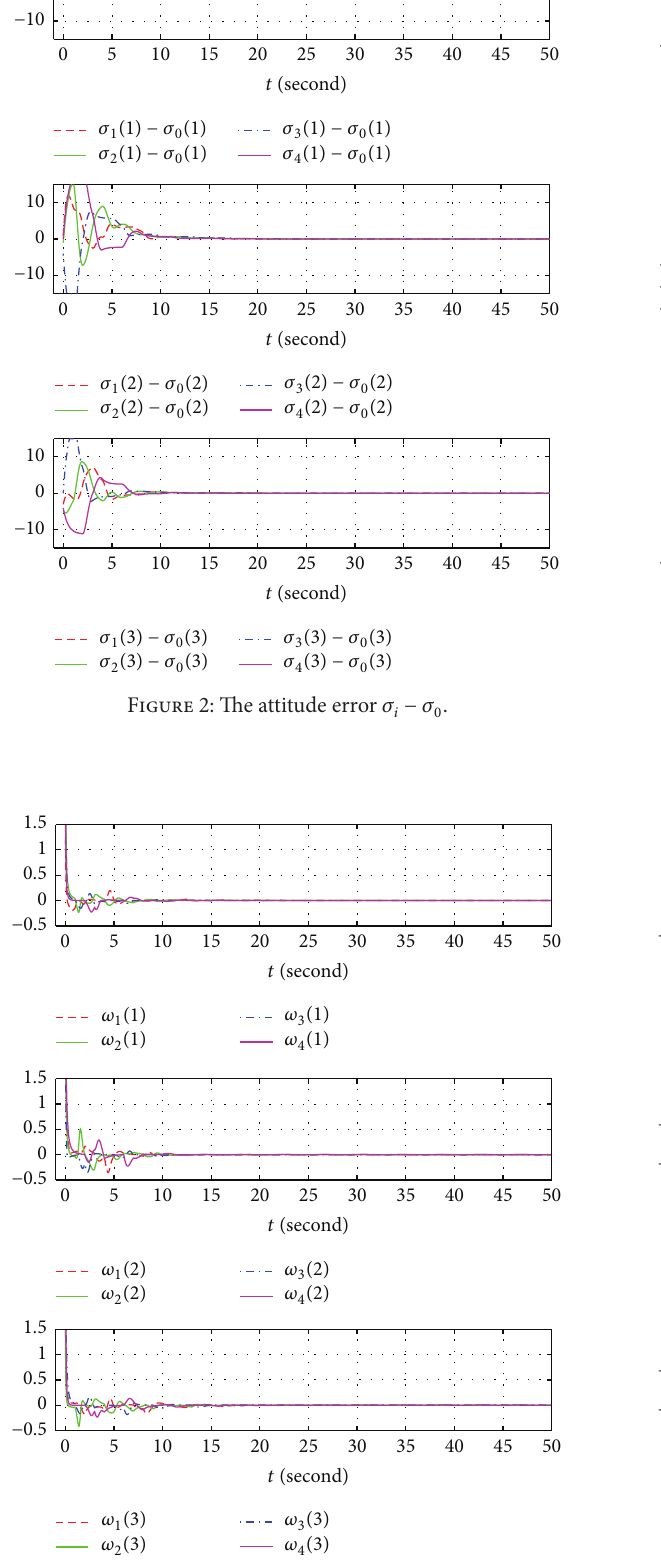
Figure 5: The attitude error 𝜎 𝑖 − 𝜎 0